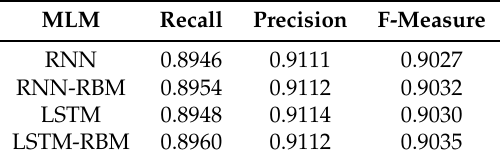
Table 5. Results for MLMs on the software piano “StbgTGd2”. MLM, music language model.